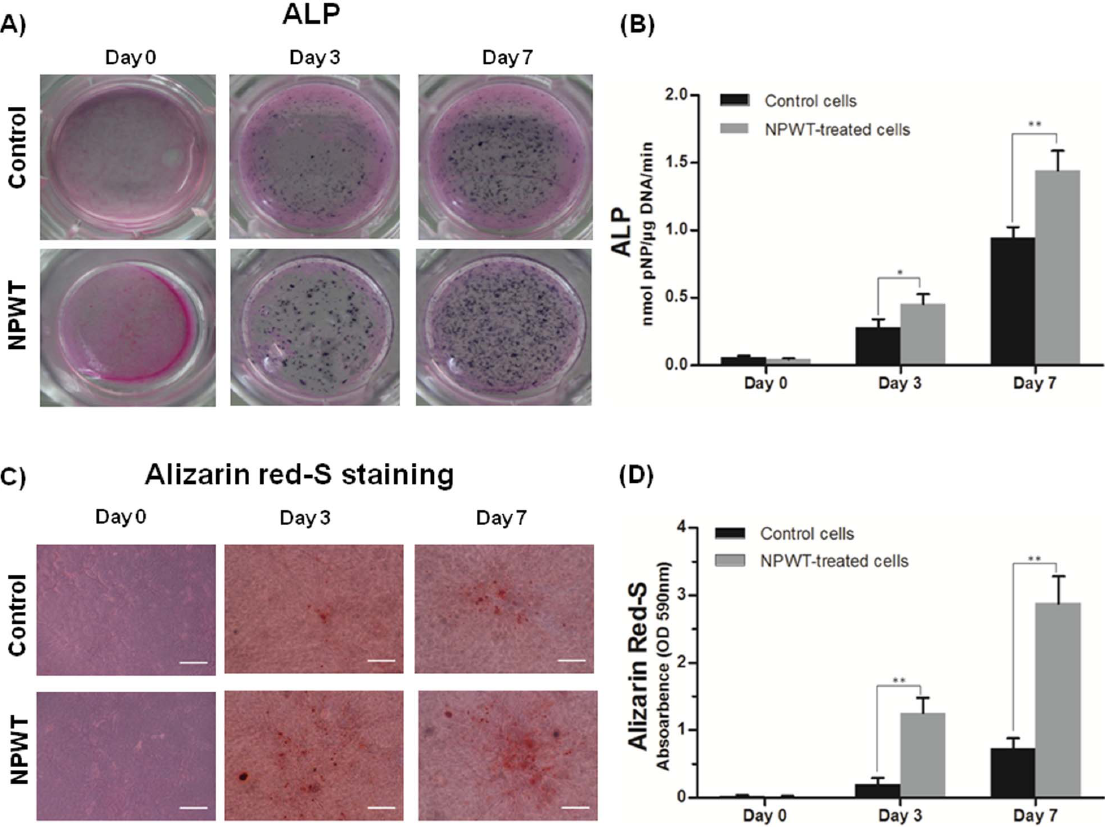
Figure 4. The expression of ALP and alizarin red-S staining. (A) Images of ALP staining of rat P-MSCs with or without NPWT treatment of different daily duration for 7 days. (B) ALP activity in P-MSCs treated with NPWT was notably higher than that in control group (* p , 0.05, ** p , 0.01). (C) Result of alizarin red-S staining was in accordance with ALP staining (Bars=50 m m). (D) Result of semi-quantitative analysis of alizarin red-S showed that absorbance index in NPWT group was significantly higher than that in control group (** p , 0.01).